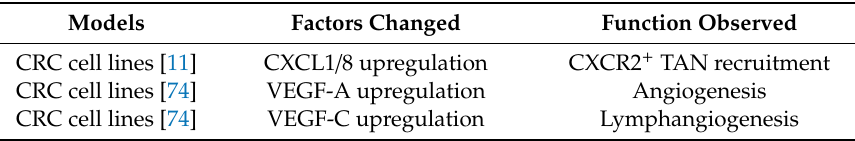
Table 2. SMAD4 loss-induced changes in